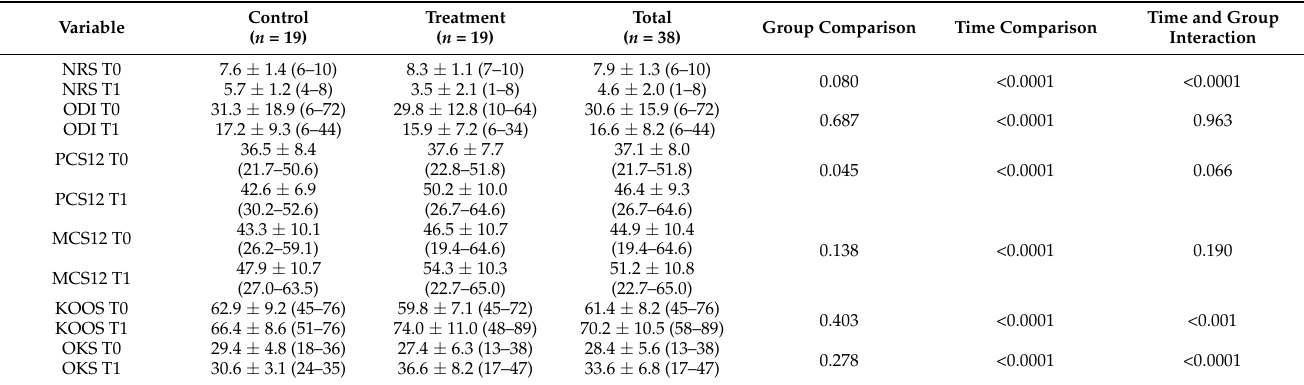
Table 2. Mean ± SD and range of outcome variables, by group and detection